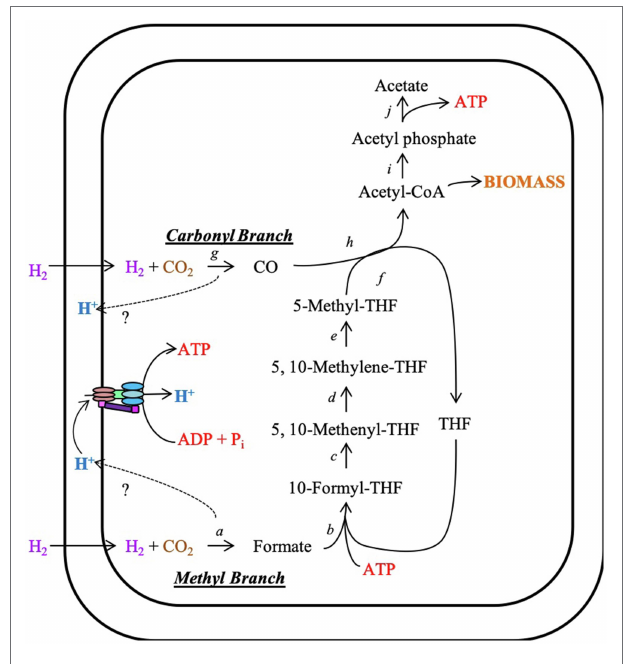
FIGURE 2 | The Wood–Ljungdahl pathway for carbon fixation. The acetogenic Wood–Ljungdahl pathway (or acetyl-CoA) pathway for carbon fixation uses molecular hydrogen and carbon dioxide to produce acetate, generating ATP. If needed, acetyl-CoA can be rerouted for biomass production. The enzymes in this pathway are as follows: a , formate dehydrogenase; b , formyl-H 4 folate synthase; c , formyl-H 4